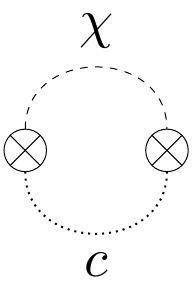
Figure 2. The diagram contributing to C